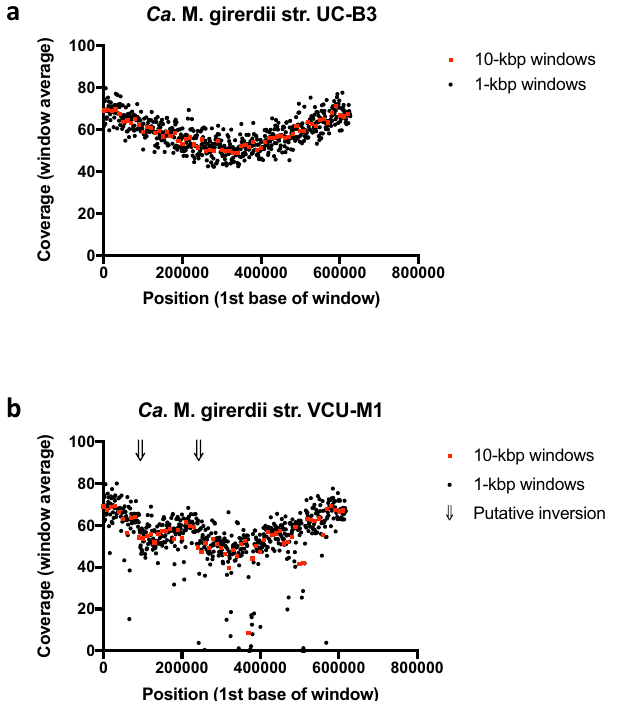
Figure 1. Pattern of sequencing read coverage suggests in vivo growth of Ca . M. girerdii strain UC-B3 and large-scale genome inversion with respect to strain VCU-M1. For each window, the average number of reads aligned to each base is plotted against the genome position corresponding to the first base. Windows are non-overlapping and sized at 10 kbp (red squares) or 1 kbp (black circles). For both panels, the aligned reads are those generated for the present study (i.e., the infant oral metagenomic reads). As a proxy for the origin of replication, the first base of each genome was set to the first base of dnaA . ( a ) Read alignment to the strain UC-B3 genome (this study) reveals a peak-to-trough ratio of ~1.4 (iRep = 1.42), suggesting active replication forks at the time of sampling. ( b ) Read alignment to the strain VCU-M1 genome 16 confirms a large-scale inversion initially revealed by the whole genome alignment (Supplementary Fig. S3). Arrows indicate putative inversion break